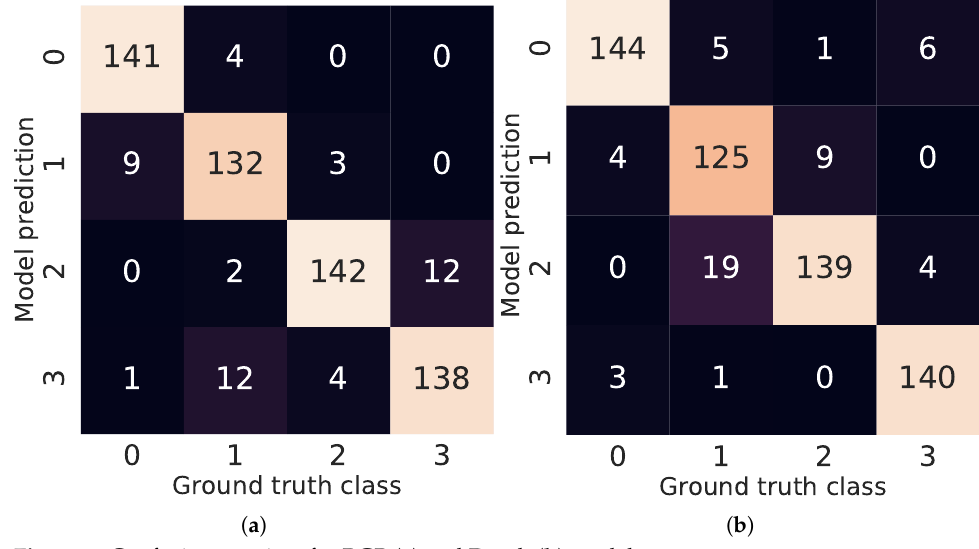
Figure 8. Confusion matrices for RGB ( a ) and Depth ( b ) models.